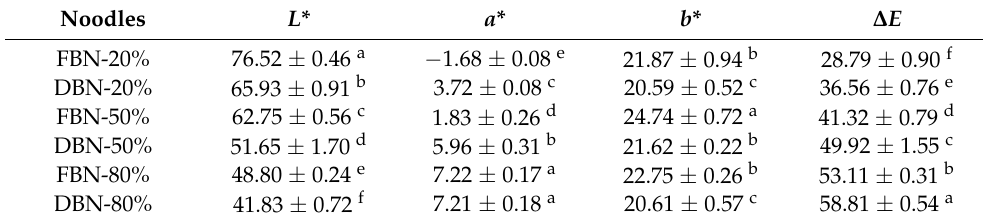
Table 2. Colour of uncooked FBN and